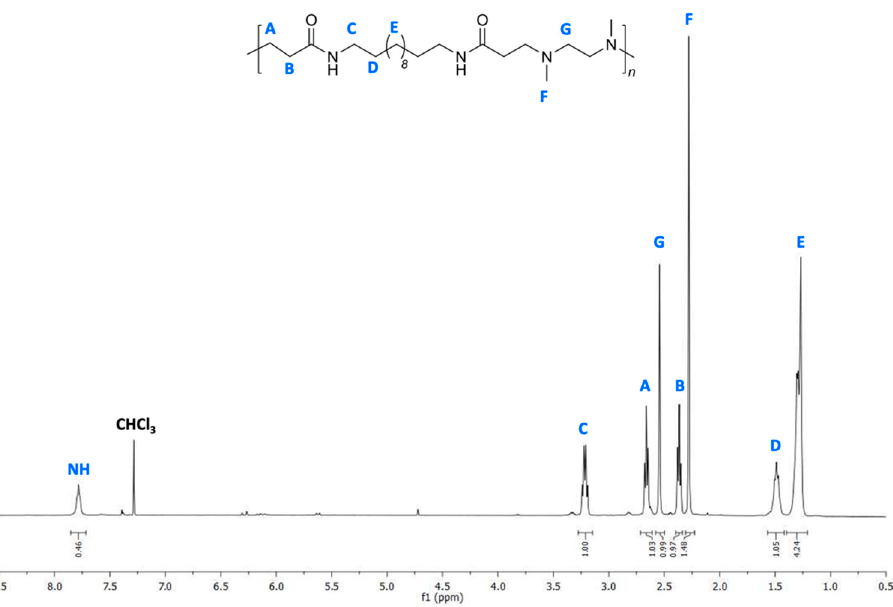
Figure 2. 1 H-NMR spectrum of H-PAA B12-DM2 obtained in CDCl 3 using a 400 MHz Avance Brüker spectrometer.